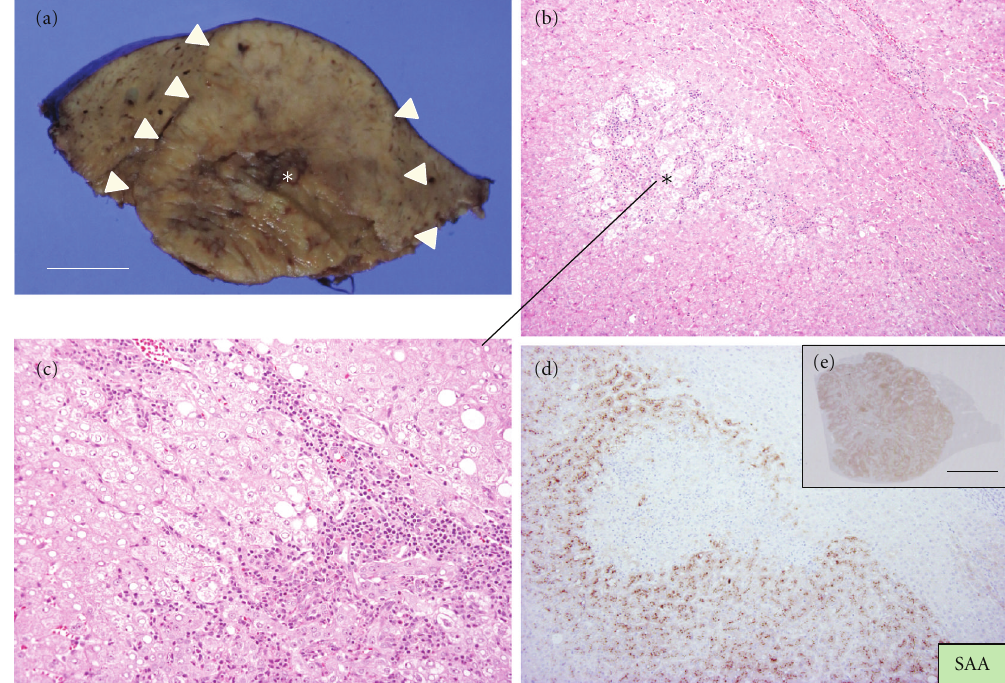
Figure 1: Inflammatory hepatocellular adenoma (HCA). (a) Cut surface shows whitish nodular lesion sized 3cm in diameter (arrowheads). There was no capsule and the border between nodule and background liver is unclear. Congestion or bleeding is observed inside the nodule (asterisk). Bar = 1cm. (b) Border of HCA and background liver. Ductular reaction is focally seen in HCA (asterisk). HE, × 100. (c) Ductular reaction with lymphoid cells infiltration in HCA. HE, × 200. (d) Strong expression of serum amyloid A component (SAA) in HCA in contrast to the background liver. Immunostaining for SAA and hematoxylin. × 100. (e) bar = 1cm.